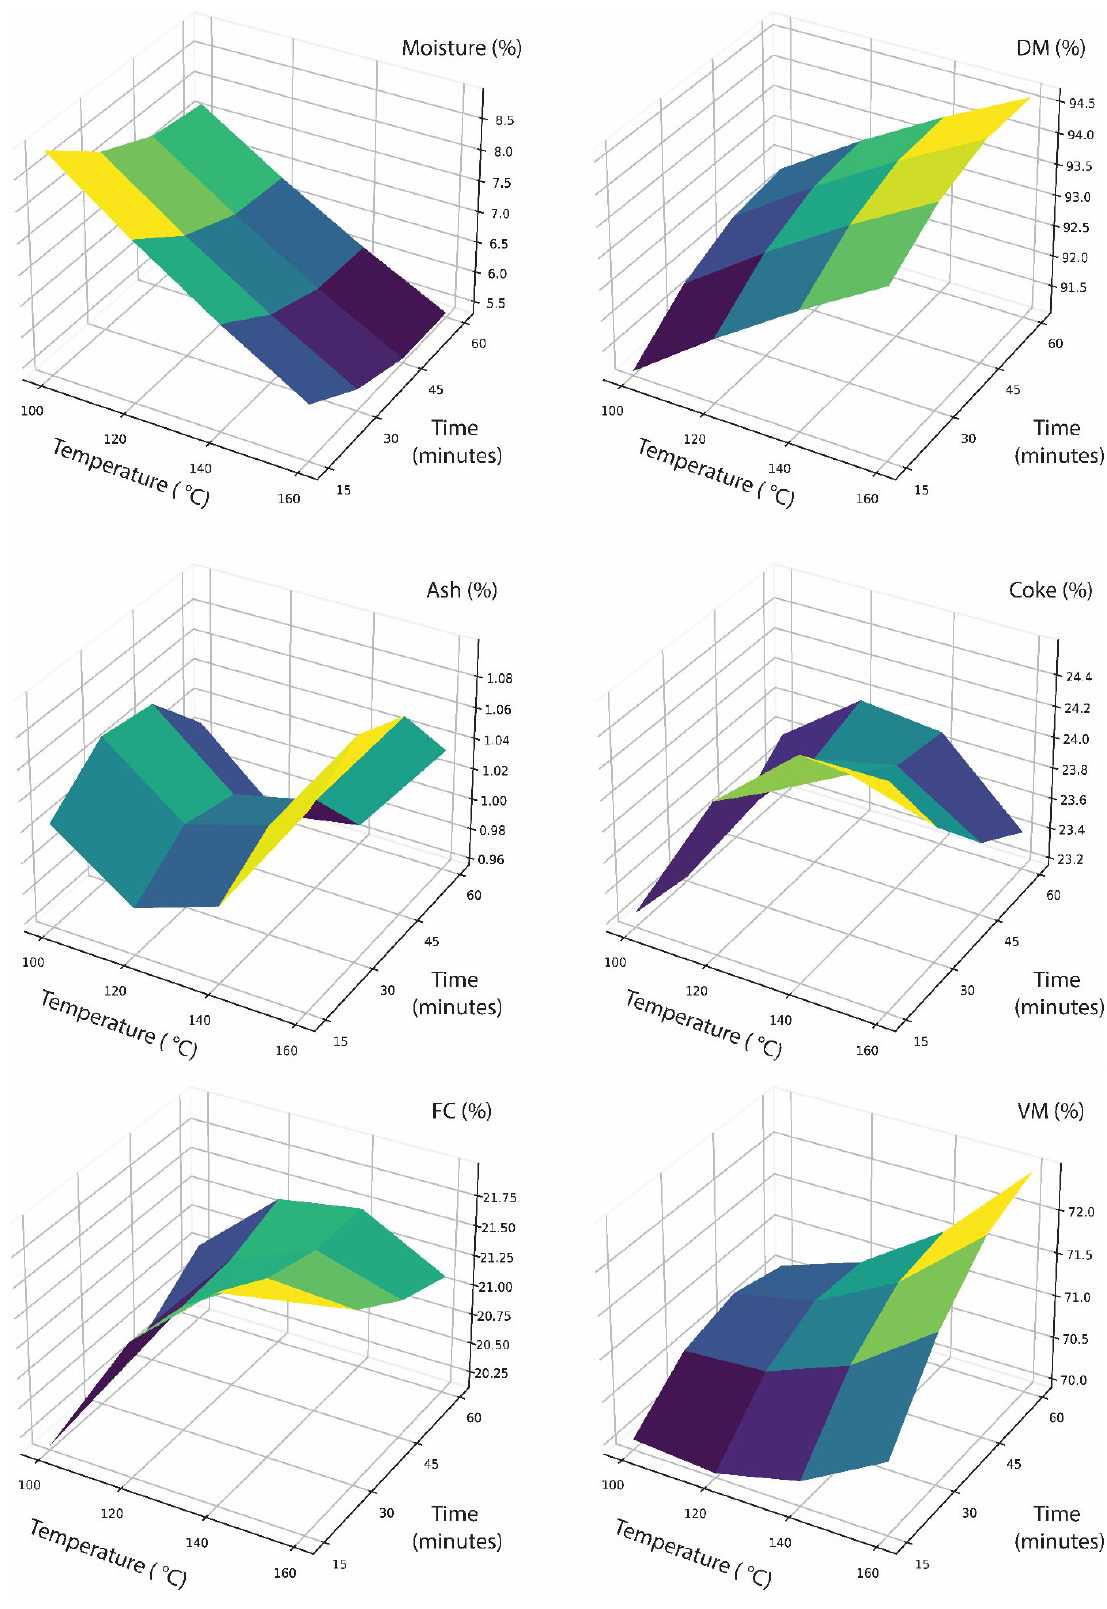
Figure 1. Response surface methodology (RSM) for fitting second-degree polynomial models in order to predict variables in proximate analysis as a function of temperature and time.